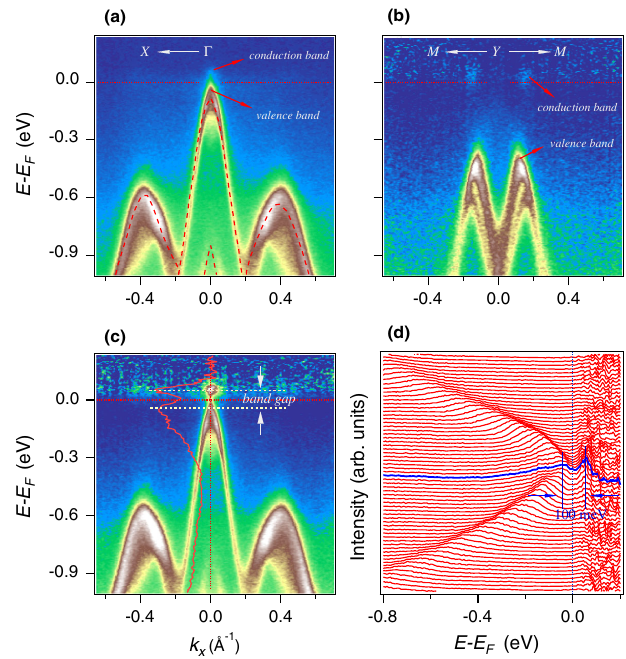
FIG. 3. Band structure of lightly substituted ZrTe 5 with a Þ Te nominal composition ð Zr 0 Ta 0 5 recorded at 190 K. . 9975 . 0025 (a) Intensity plot of the band dispersions along Γ - X . Dashed curves represent the extracted bands of the pristine ZrTe 5 recorded at 200 K, which are shifted down by 50 meV to match the band dispersions of the substituted one. (b),(c) Intensity plots of the band dispersions along Y - M and Γ - X , respectively, divided by the FD distribution function ( T ¼ 190 K) convoluted with the energy resolution Gaussian function ( Δ E ¼ 25 meV). The red curve in (c) is the energy distribution curve at Γ . (d) Energy distribution curve plot of